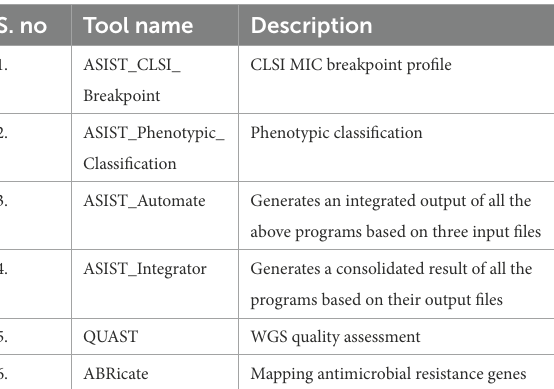
TABLE 1 Galaxy-ASIST toolkit.